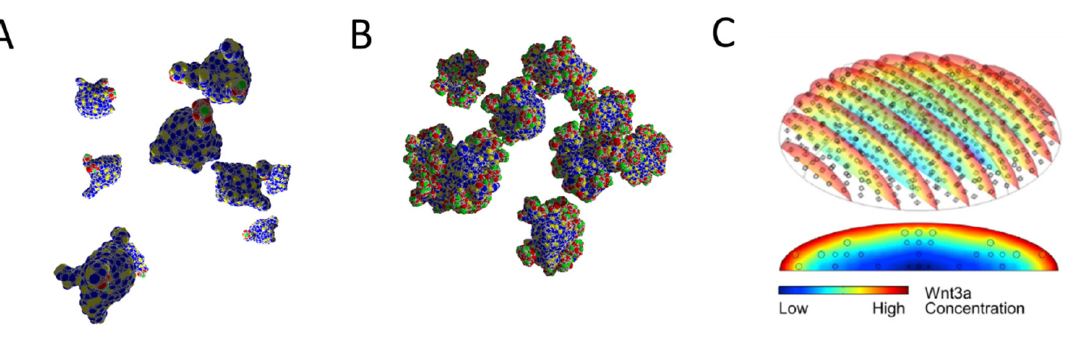
Figure 4. Simulated populations of organoids. The model provided by Thalheim et al. [11] enables controlling Wnt and Notch activity in the cells via cell–cell interaction. PCs provide both Wnt and Notch ligands which are necessary for SC maintenance. The number of contacts N required to stabilize the SC fate controls the SC fraction and thus organoid shape and growth velocity. ( A ) N = 1 after 42 days of culture, ( B ) N = 2 after 21 days of culture. These differences can be motivated by externally provided growth factors. Colors of the cells as in Figures 1B and 2C. ( C ) In contrast to the assumptions by Thalheim et al. [11], the growth factors (here Wnt3a) are not homogeneously distributed in the culture [40], potentially resulting in mixtures of the growth types. Small circles: organoids. Figure 4C is published under Creative Commons CC-BY-NC-ND, all rights are reserved by the publisher.